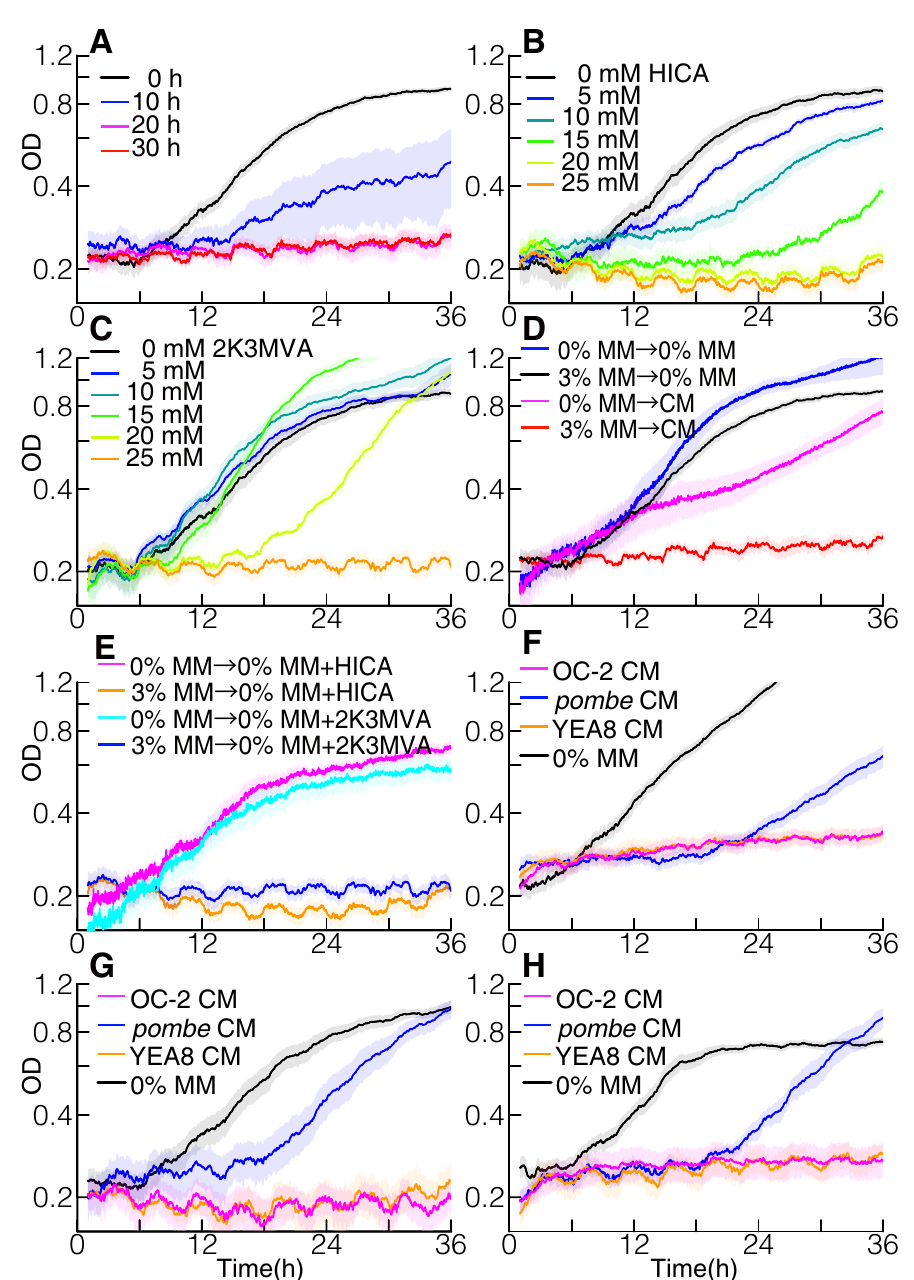
Fig 4. Media conditioned with various strains of yeasts initiated the delay phase. ( A ) Growth curves of S . cerevisiae (OC-2) cells in media conditioned with themselves. Different colored lines indicate growth curves of CM at different incubation times. Each line represents an average of n � 6 samples. ( B ) Growth curves of OC-2 in 0% MM with various concentrations of HICA. Each line represents an average of n � 5 samples. ( C ) Growth curves of OC-2 in 0% MM with various concentrations of 2K3MVA. Each line represents an average of n � 5 samples. ( D ) Growth curves of OC-2 precultured in 0% or 3% MM grown in OC-2 CM. Each line represents an average of n � 6 samples. ( E ) Growth curves of OC-2 precultured in 0% or 3% MM grown in 0% MM with 25 mM HICA or 25 mM 2K3MVA. Each line represents an average of n � 6 samples. ( F , G , and H ) Growth curves of ( F ) S . pombe , ( G ) OC-2, and ( H ) YEA8 in media conditioned with S . pombe , OC-2, or YEA8 for 30 h. Each line represents an average of n � 6 samples. The data underlying this figure can be found in S1 Data. CM, conditioned media; MM, minimal